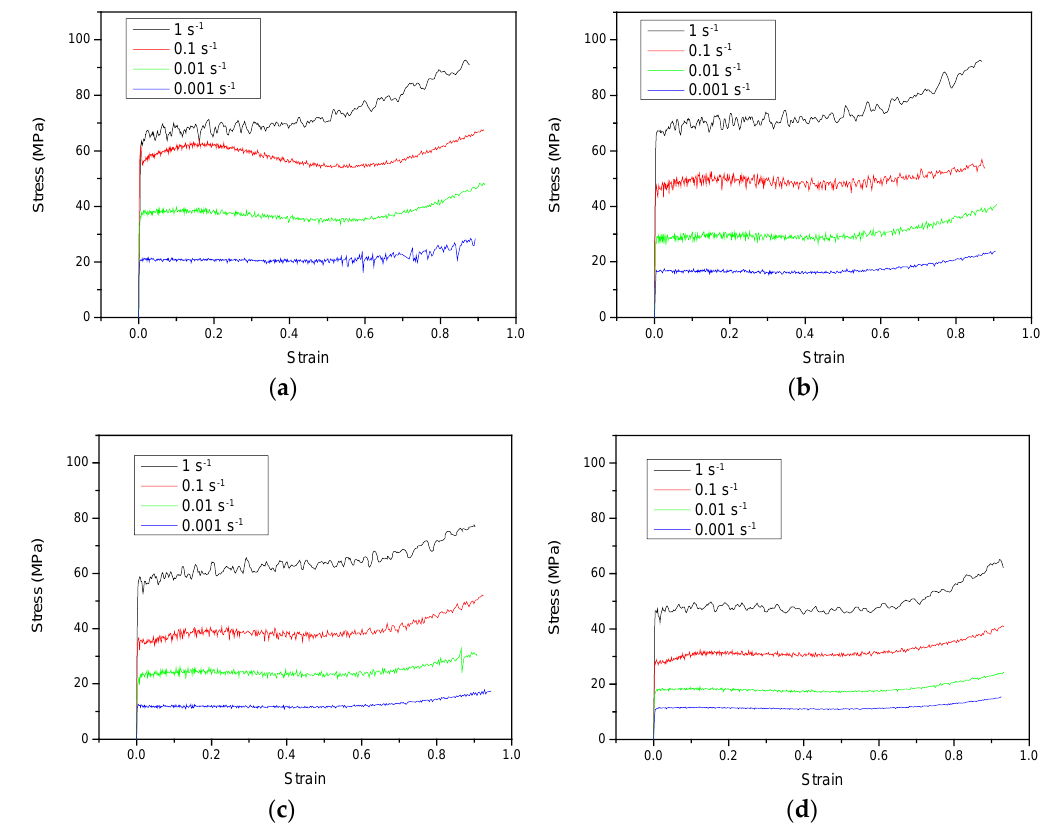
Figure 2. True stress − strain curves of the specimens which height reduction is 60% under different deformation conditions: ( a ) 1000 °C; ( b ) 1050 °C; ( c ) 1100 °C; and ( d ) 1150 °C.